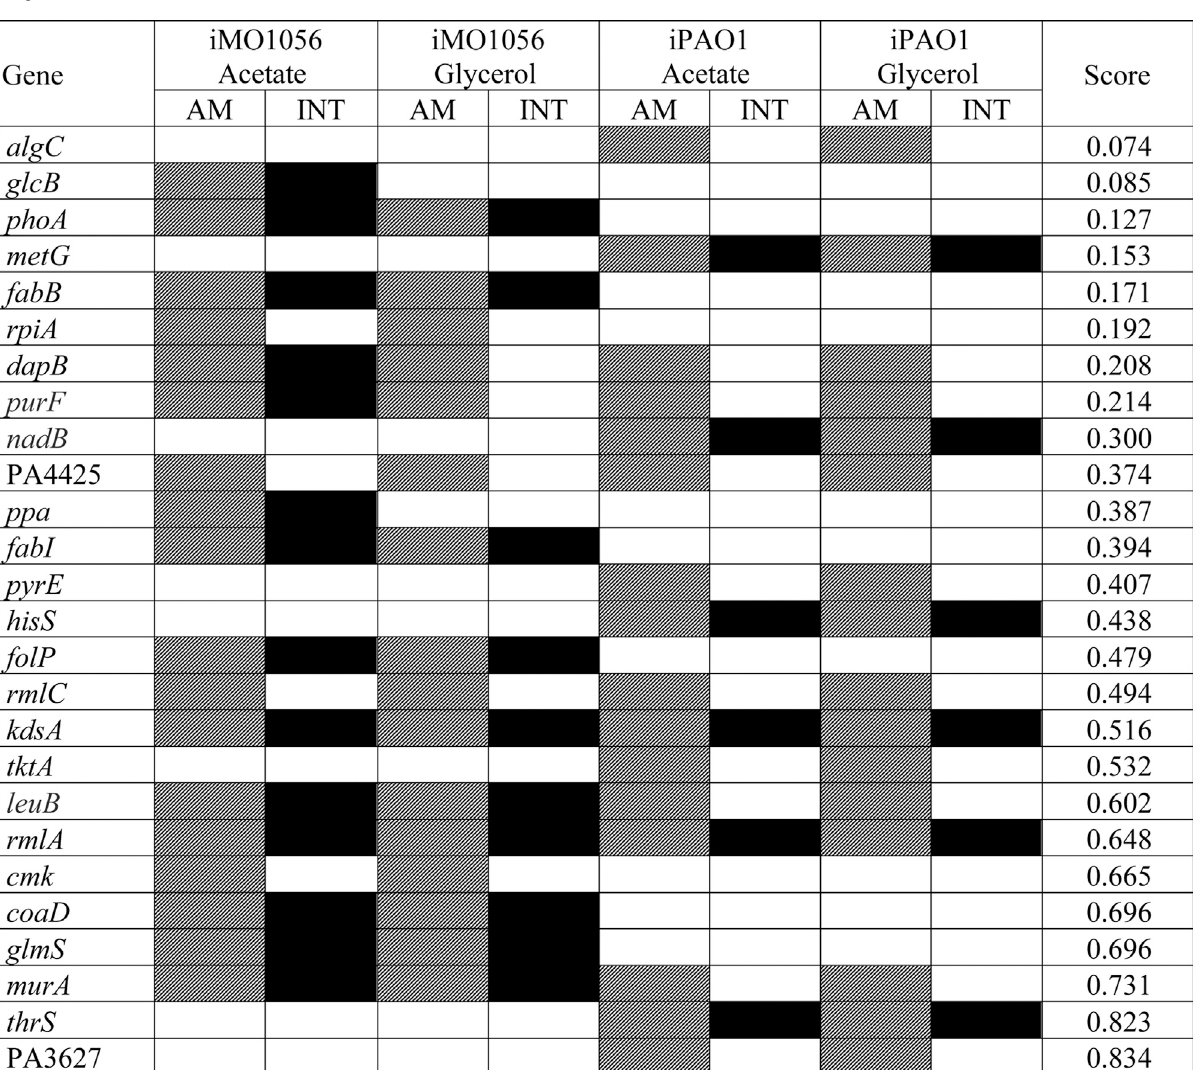
TABLE 1 | List of potential therapeutic targets identi fi ed by the FindTargetWEB application from the metabolic models with adjusted carbon source uptake rates and integrated models.